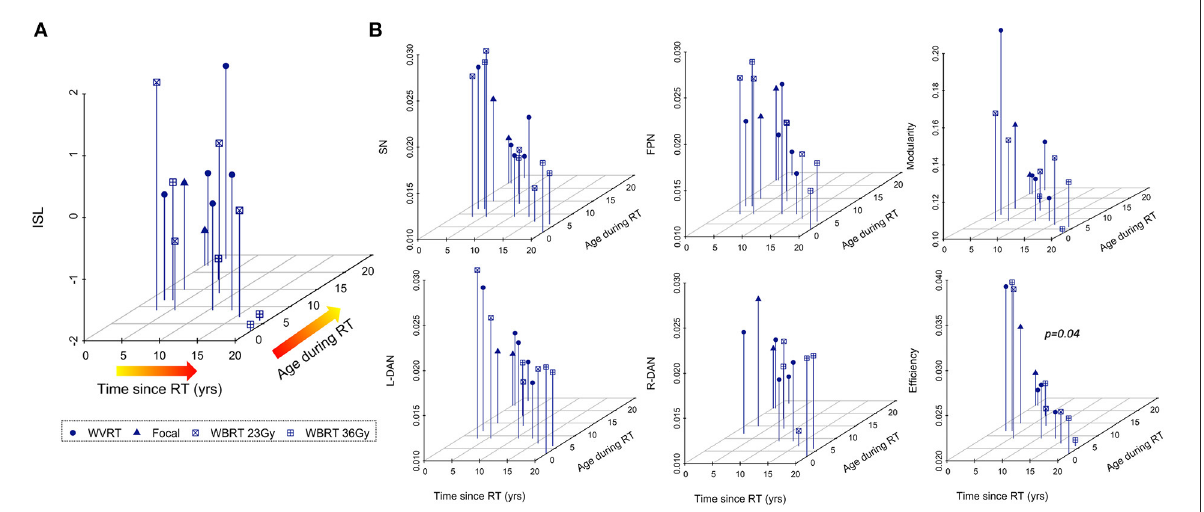
FIGURE7 Age-normalized MR metrics are strongly associated with risk factors for cognitive decline after RT. Neurocognitive memory performance measured via the international shopping list (ISL) task is less associated with known risk factors for neurocognitive decline after RT (A) than MR metrics (B) representing surrogate markers of neurocognitive